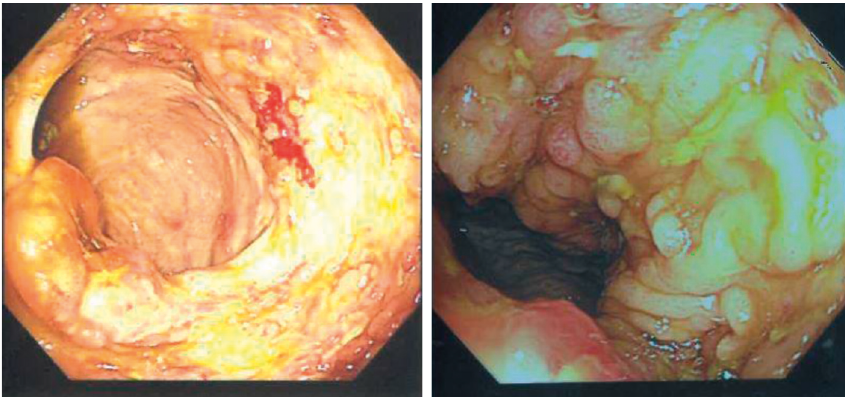
Figure 1: Colonoscopy: ulcerations and polyps in the ileocecal region and ascending colon.